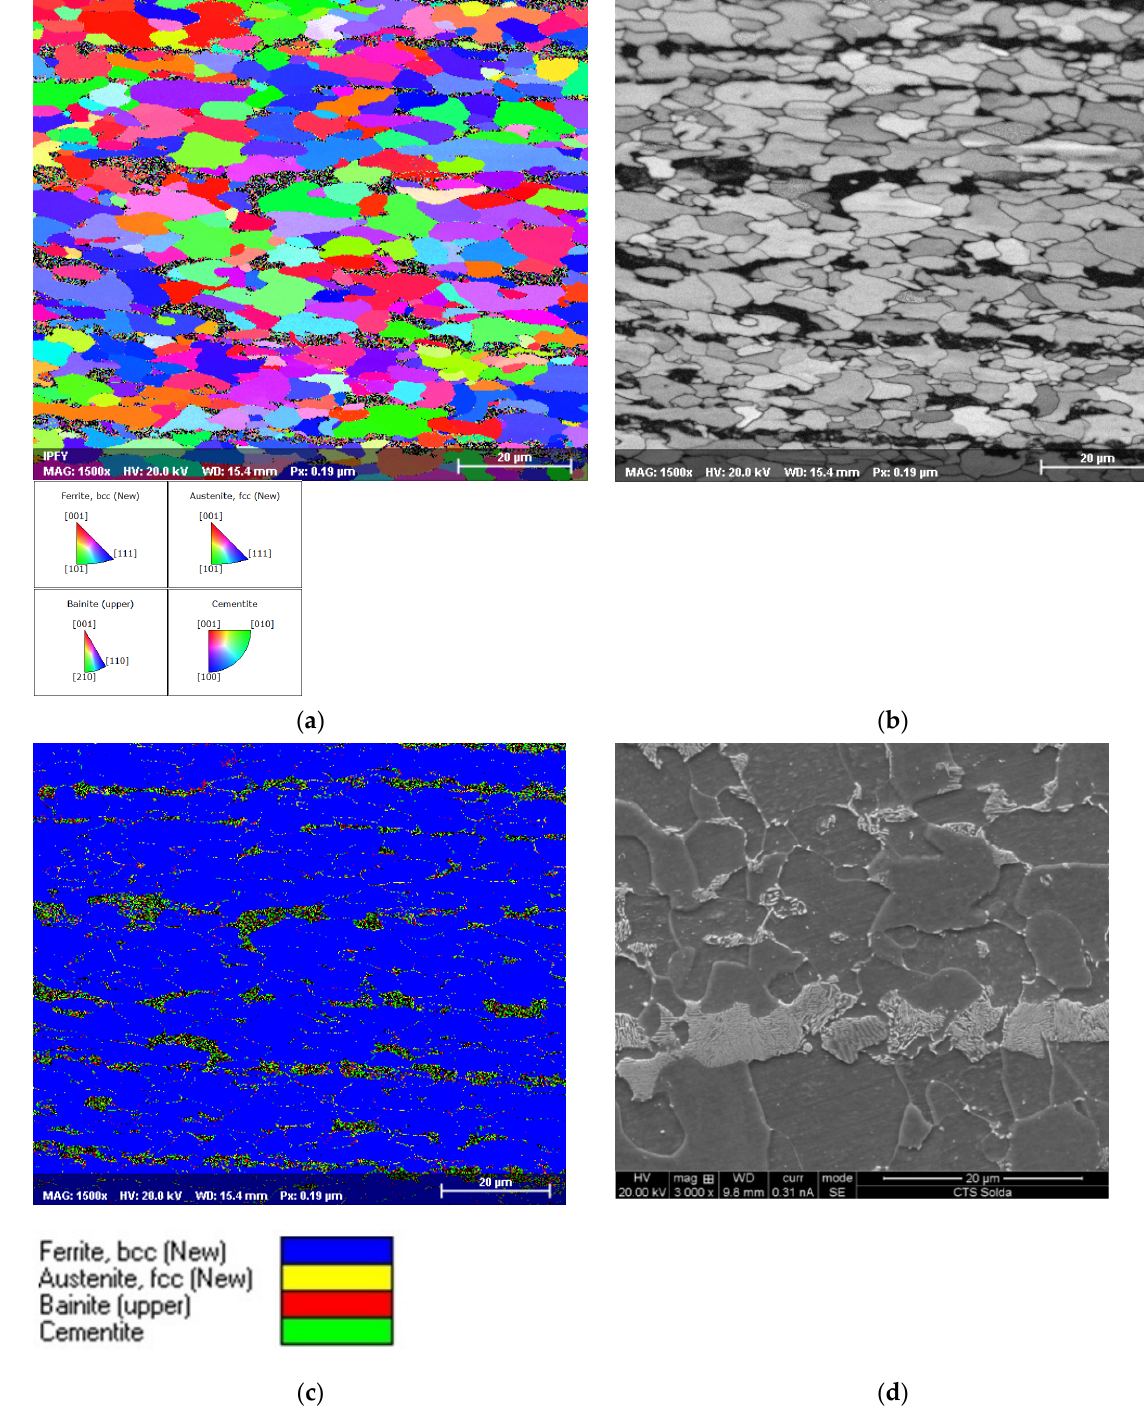
Figure 6. Micrographs of the base material obtained with EBSD: ( a ) inverse pole figure (IPF) normal to the Y axis, ( b ) map of the quality standard, and ( c ) phase distribution map. Magnitude of 1500×. ( d ) Electron microscopy micrograph with magnitude of 3000×.